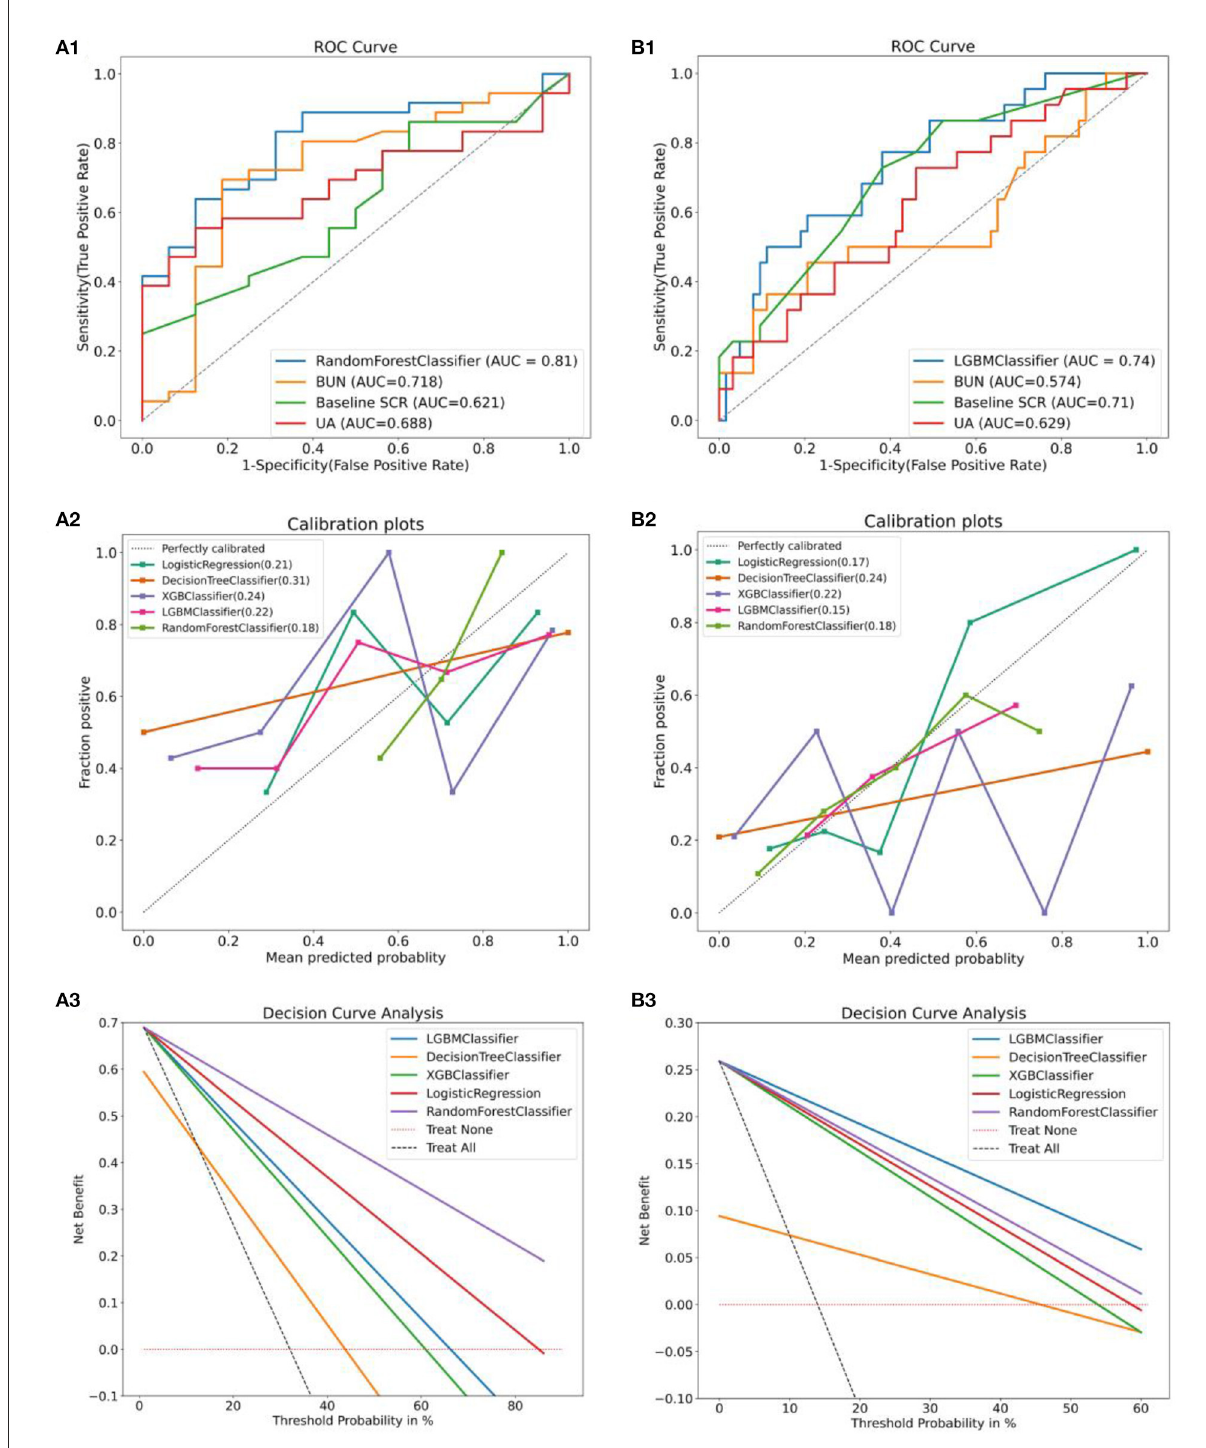
FIGURE7 Evaluation and validation of the two models. (A1,B1) are comparisons of the performance of the compact model after feature selection with the prediction performance of AKI occurrence in the test set using baseline SCR, BUN and UA alone. (A2,B2) are the calibration curves for different machine learning models and the Brier scores. (A3,B3) are the clinical decision curves for the different machine learning models. The gray dashed line is the benefit rate for all patients who received the intervention, and the pink dashed horizontal line is no benefit for all patients who did not receive the intervention. The intersection with all is taken as the starting point and the intersection with None as the ending point, within which is the corresponding total net